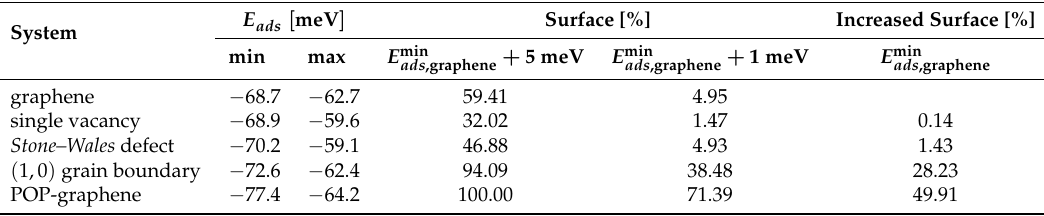
Table 4. Summary of the adsorption characteristics: minimum and maximum values of adsorption maps for different scenarios (Figure 3, fraction of the surface (in the used supercell) with adsorption energy in the range of adsorption minimum of pristine graphene E min + 5meV, and fraction of the supercell area with adsorption energy lower than that of E min ads ,graphene pristine graphene. The values of +1 meV and +5 meV, were chosen